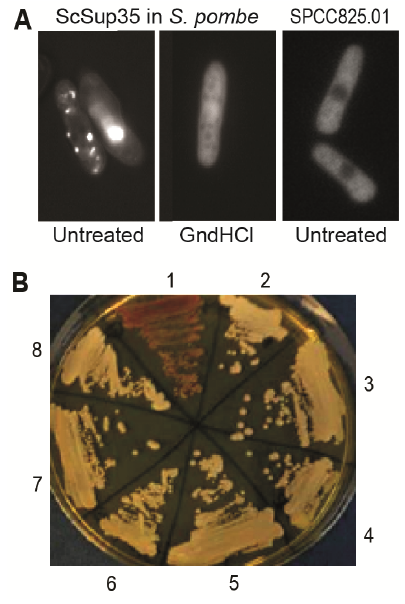
FIGURE 1: Fission yeast can support formation and propagation of the budding yeast [ PSI + ] prion. (A) Left: Fluorescent foci in S. pombe resulting from overexpression of S. cerevisiae Sup35-GFP, using the medium-strength, regulatable nmt41 promoter under activating conditions from a high-copy plasmid. This result re- sembles the patterns seen when ScSup35-GFP is overexpressed from a high-copy plasmid in S. cerevisiae [47] . Middle: The foci are absent from cells grown for 35-40 generations in 3 mM guan- idine hydrochloride (GndHCl). Right: Most GFP-tagged S. pombe proteins do not show fluorescent foci when overexpressed (see also [54]); the uncharacterized protein SPCC825.01(predicted ATPase) serves as an example for such a negative control, show- ing diffuse cytoplasmic localization. (B) Transformation of S.